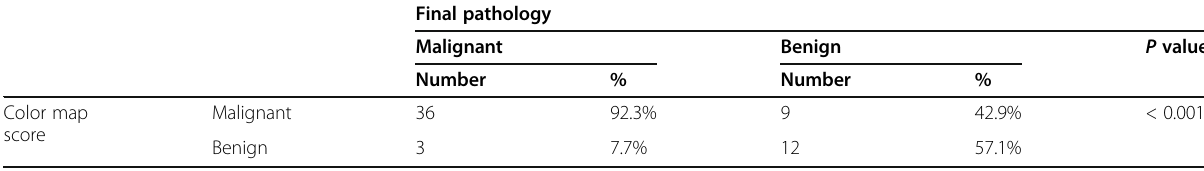
Table 4 Relation between the qualitative SE results and the final pathology